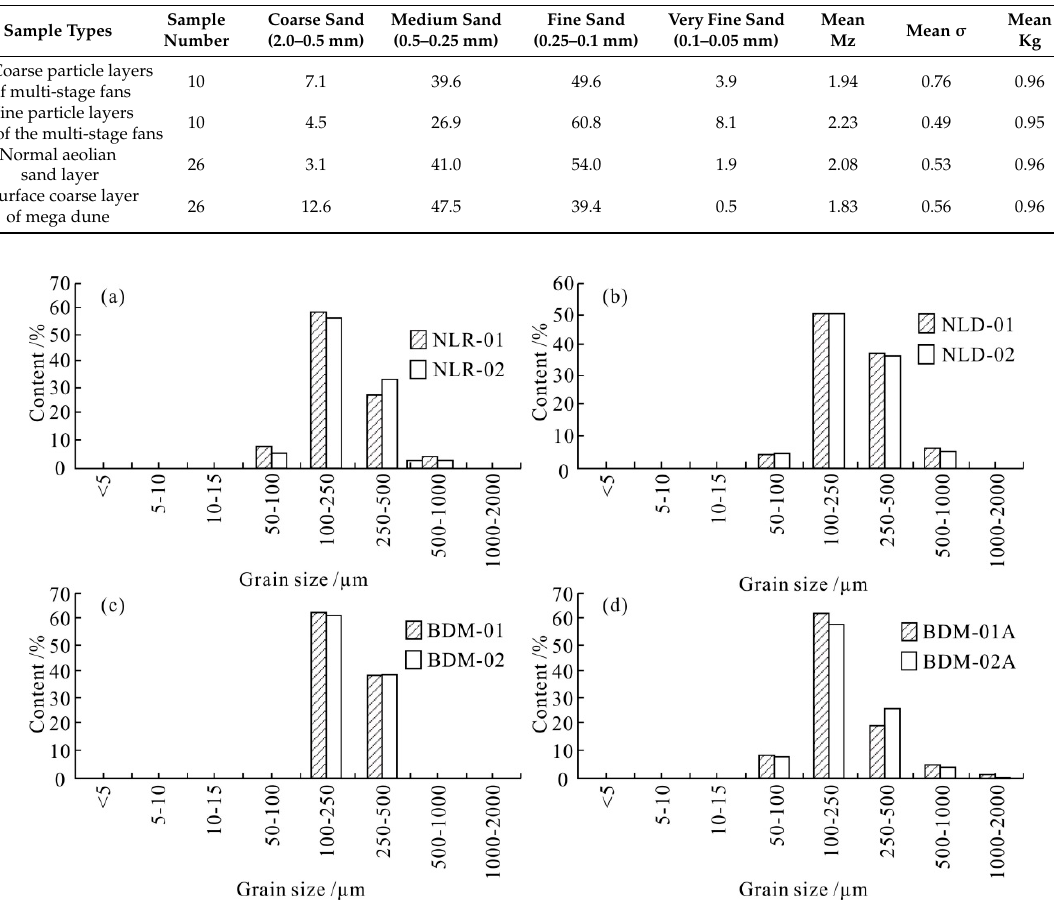
Figure 7. Particle-size distributions of samples from multi-stage fans. ( a ), ( b ) Representative samples from fine-grained layers in a multi-stage fan (samples NLR01, NLR02) and from coarse-grained layers in a multi-stage fan (samples NLD01, NLD02) in eastern Nuoertu Lake. ( c ), ( d ). Four representative samples of aeolian sand from a mega-dune in eastern Nuoertu Lake.